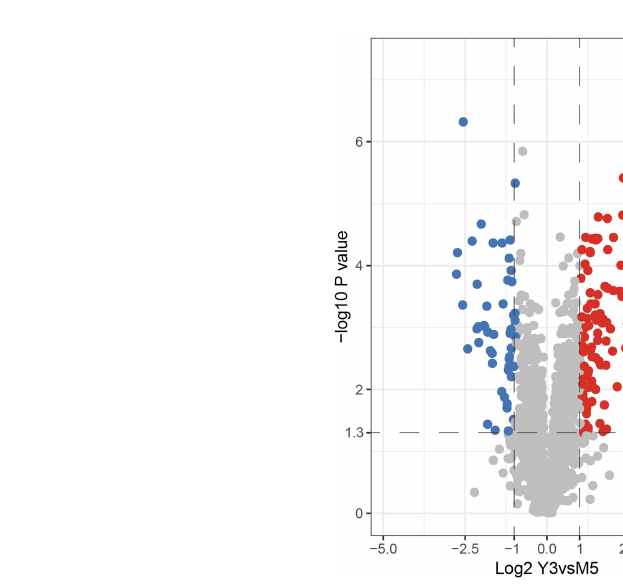
FIGURE 2 | Identi fi cation of DE proteins of B. melitensis biovar 3 and B. melitensis M5-90. The volcano plot also shows the DE proteins of B. melitensis biovar 3 and B. melitensis M5-90; red points represent hDE proteins and blue points represent lDE proteins. The protein dataset in this study is classi fi ed according to the relative abundance of the protein entries, calculated on the inter-sample (i.e. Y3 vs M5)